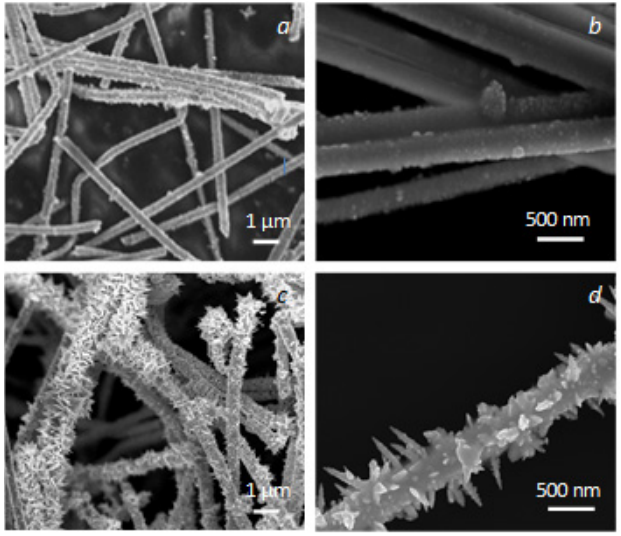
Figure 2. SEM images of Ni@Au NTs: ( a , c )—prepared with gold chloride concentrations of 0.005 M and 0.01 M, respectively. ( b , d )—the corresponding enlarged patterns.